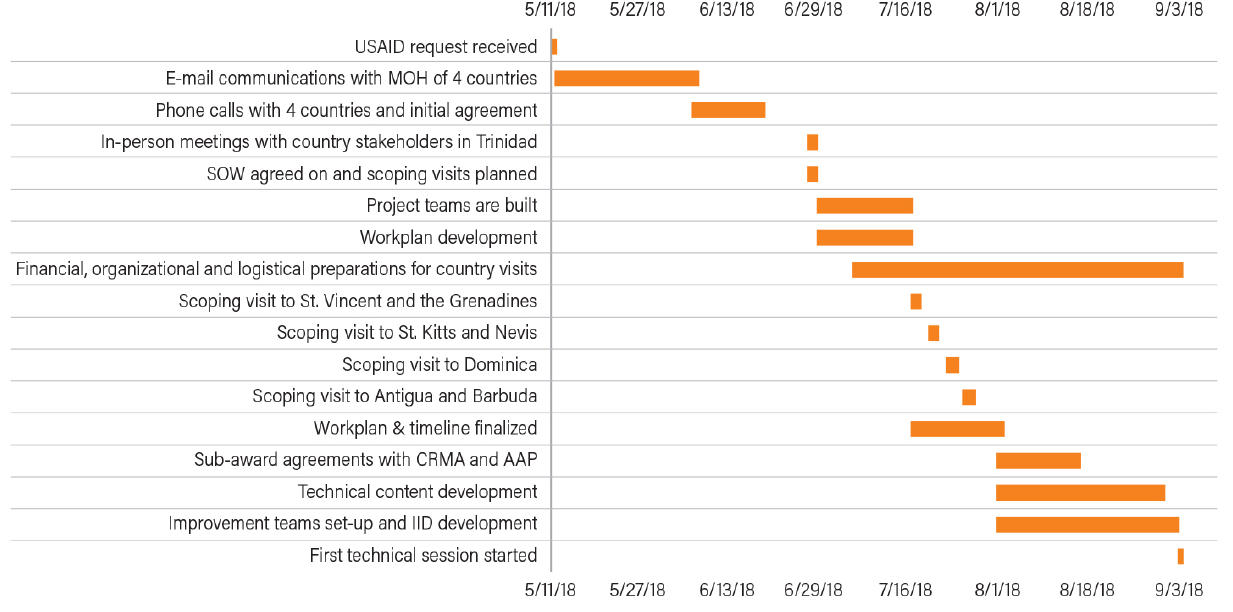
Figure 2. Timeline of key activities. AAP, American Academy of Pediatrics; CRMA, Caribbean Regional Midwives Association; MOH, Ministry of Health; SOW, Scope of Work; IID, improvement indicator